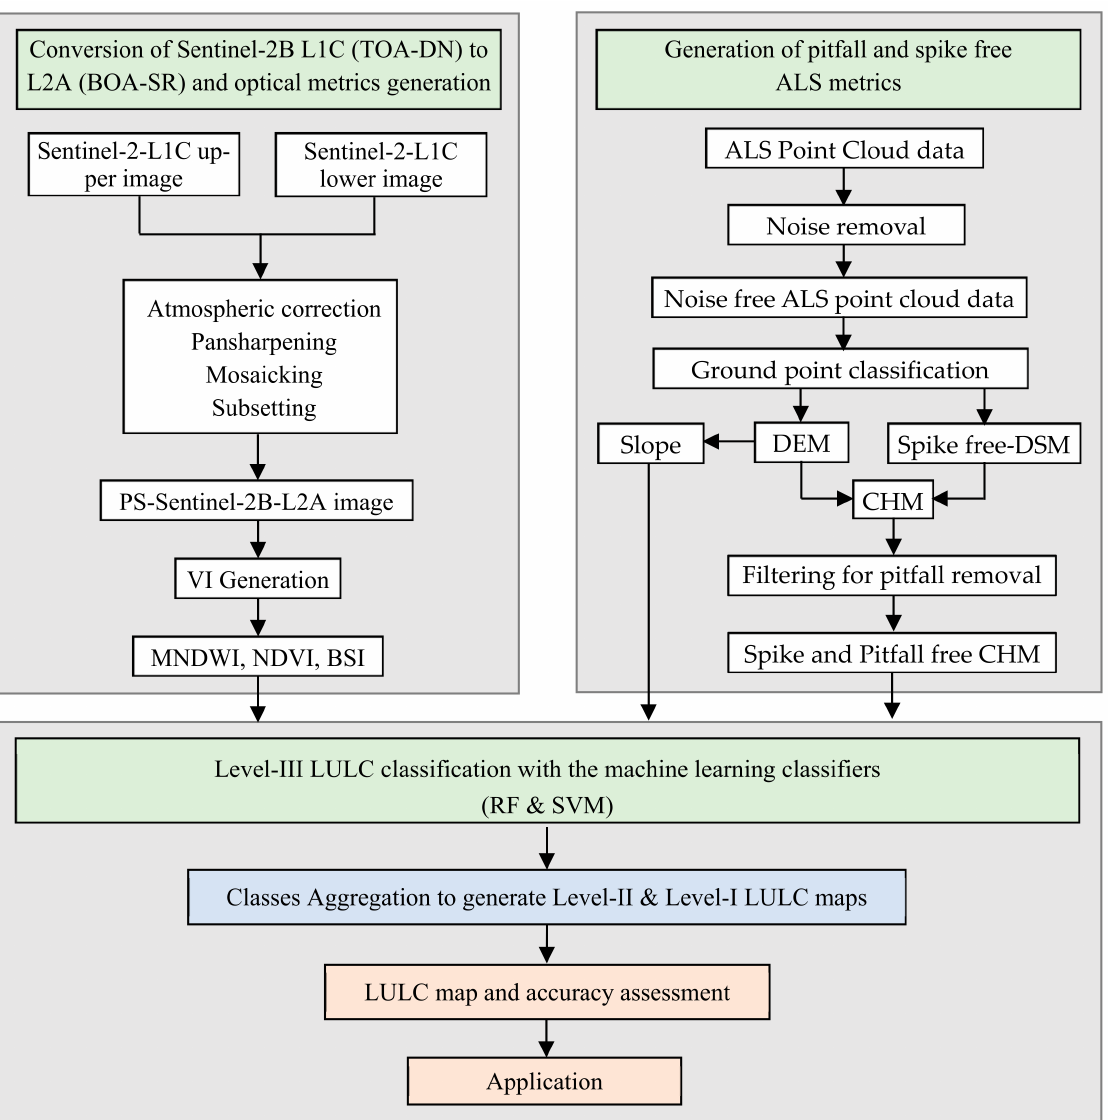
Figure 2. Flowchart of integrating Sentinel-2 and ALS data for LULC classification via RF and SVM machine learning technique. The classifications were performed using the package randomForest of [60] in R statistical software (version 4.1.2) and the SVM tool in ENVI software (version